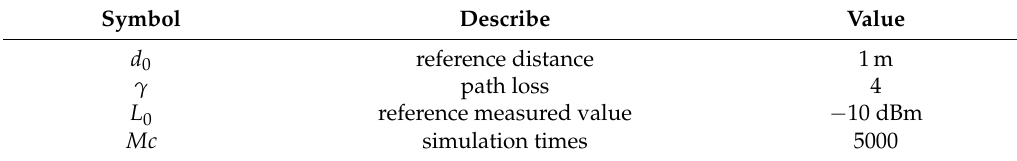
Table 2. Simulation parameter settings.